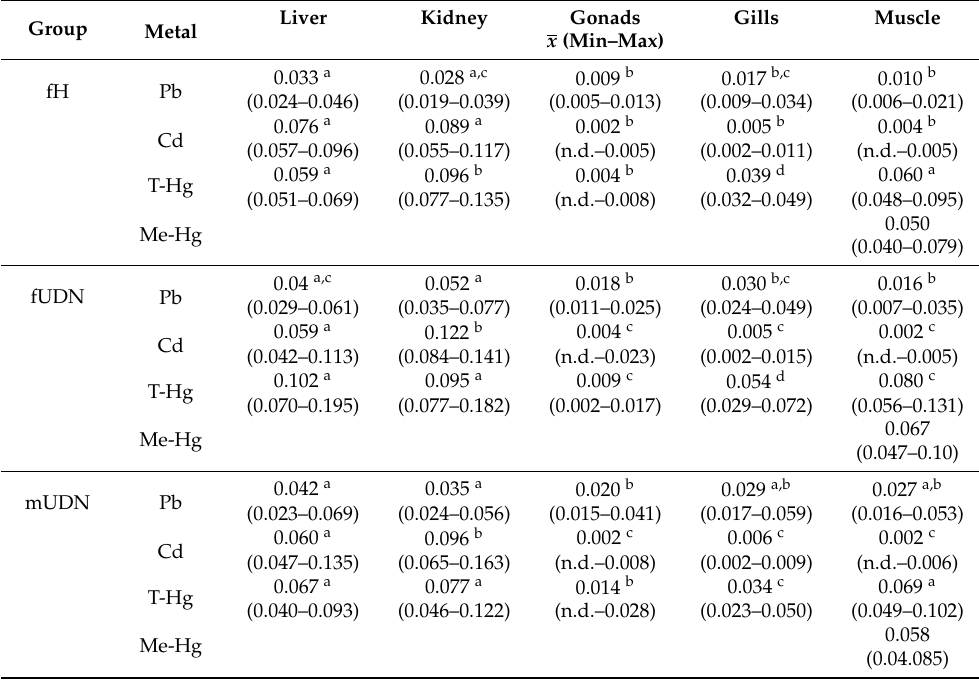
Table 3. Mean contents of Pb, Cd, and Hg in the organs of sea trout ( µ g/g